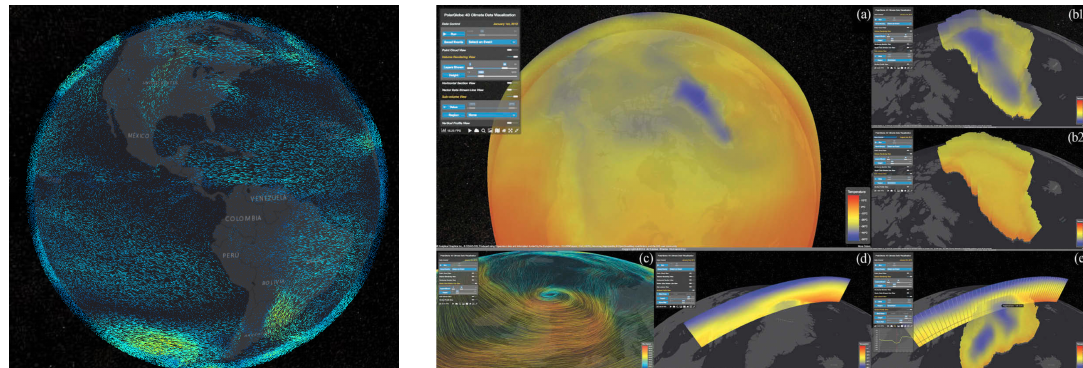
Figure 12. Left: Interactive visualization in the user interface of PolarGlobe showing wind speed on the Earths’ surface with rendered vector data. Screenshot from http://cici.lab.asu.edu/polarglobe/. Right: System demonstration of the graphic user interface of PolarGlobe indicating temperature data with animation and different modes. ( a ): Temperature in 2012 over the North Pole in panorama view of the Globe; ( b1 , b2 ): Animation of temperature data over Greenland in two different points of time; ( c ): Wind vector data of a winter cyclone; ( d ): Vertical profile visualization of temperatures; ( e ): Value picking of temperatures. Source: